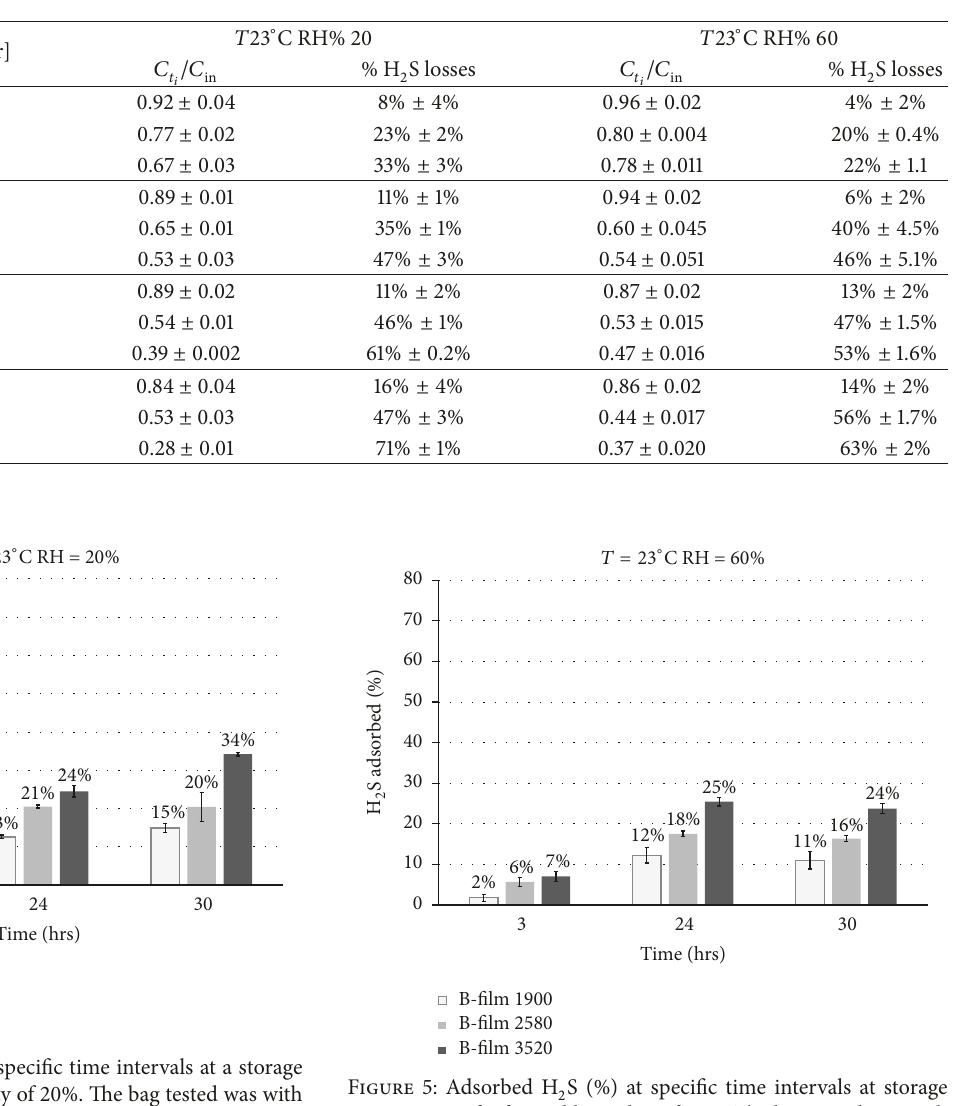
Table 3: Experimental data relevant to the H 2 S loss over time in a Nalophan bag stored at temperature of 23 ∘ C and humidity of 20% and 60%. The bag tested was without any film inside (B-no film) and with the film inside. The surface of the internal film sheet was equal to 1900 cm 2 (B-film 1900), 2580 cm 2 (B-film 2580), and 3520 cm 2 (B-film 3520), respectively. The data reported are the average of the results from three different tests performed at the same conditions.